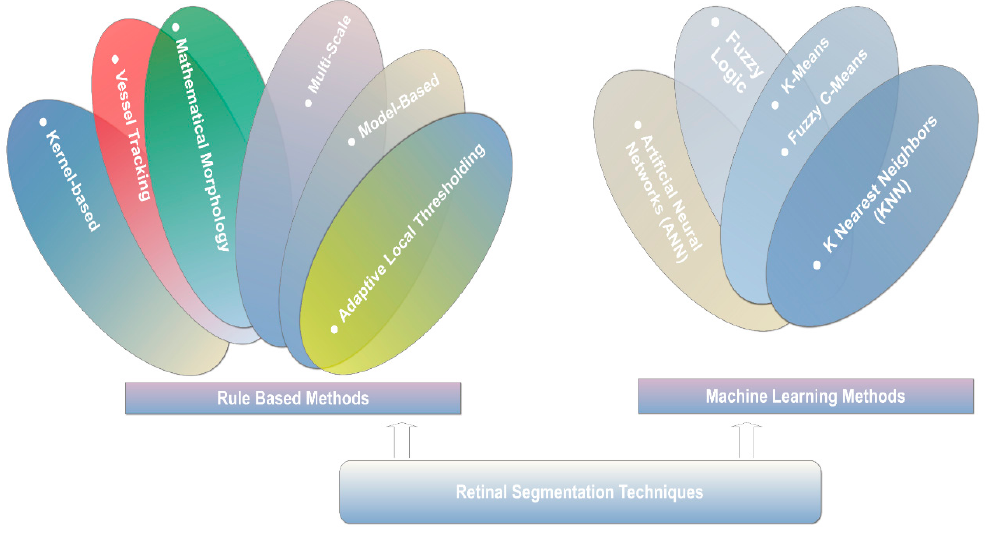
Figure 7. Retinal vessels segmentation techniques.